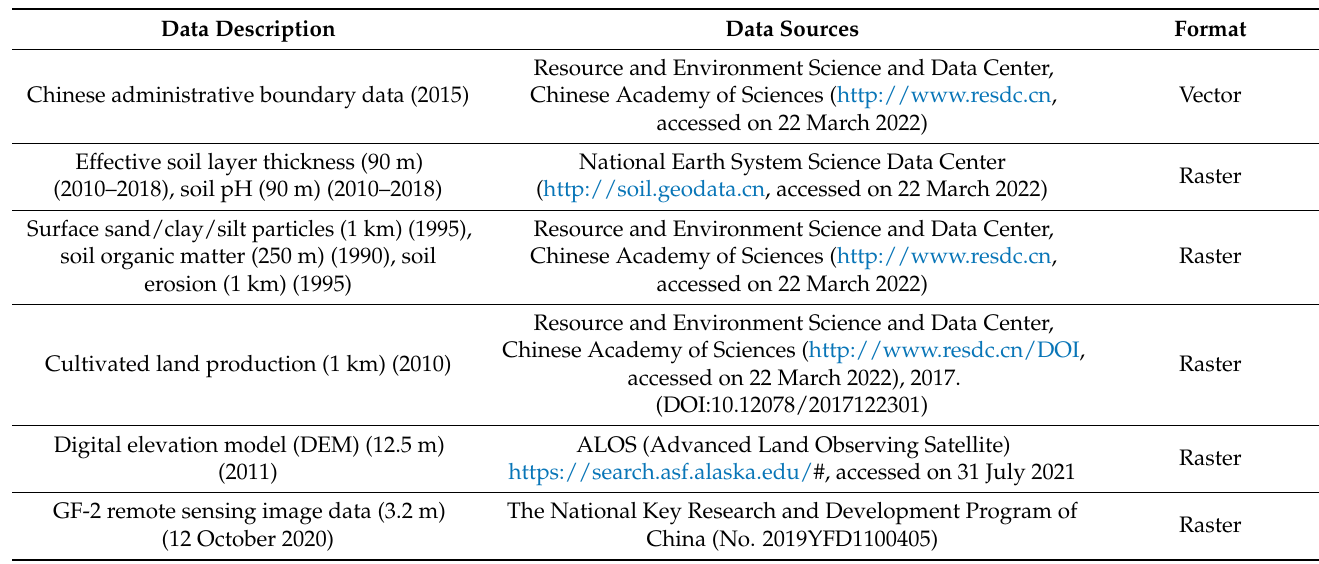
Table 1. Data sources and